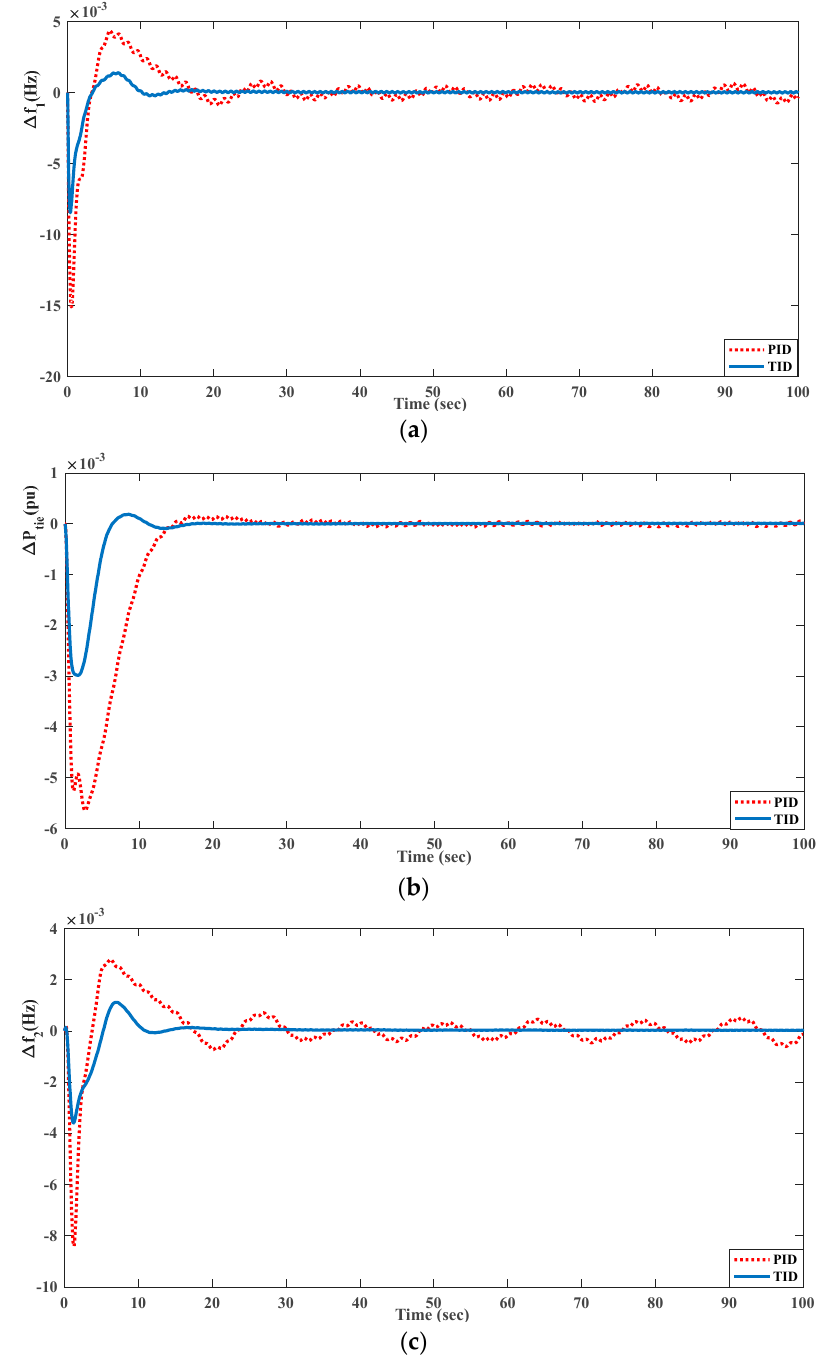
Figure 15. Comparison of PID and TID dynamics with non-linearities. ( a ) ∆ f 1 ; ( b ) ∆ P tie ; ( c ) ∆ f 2